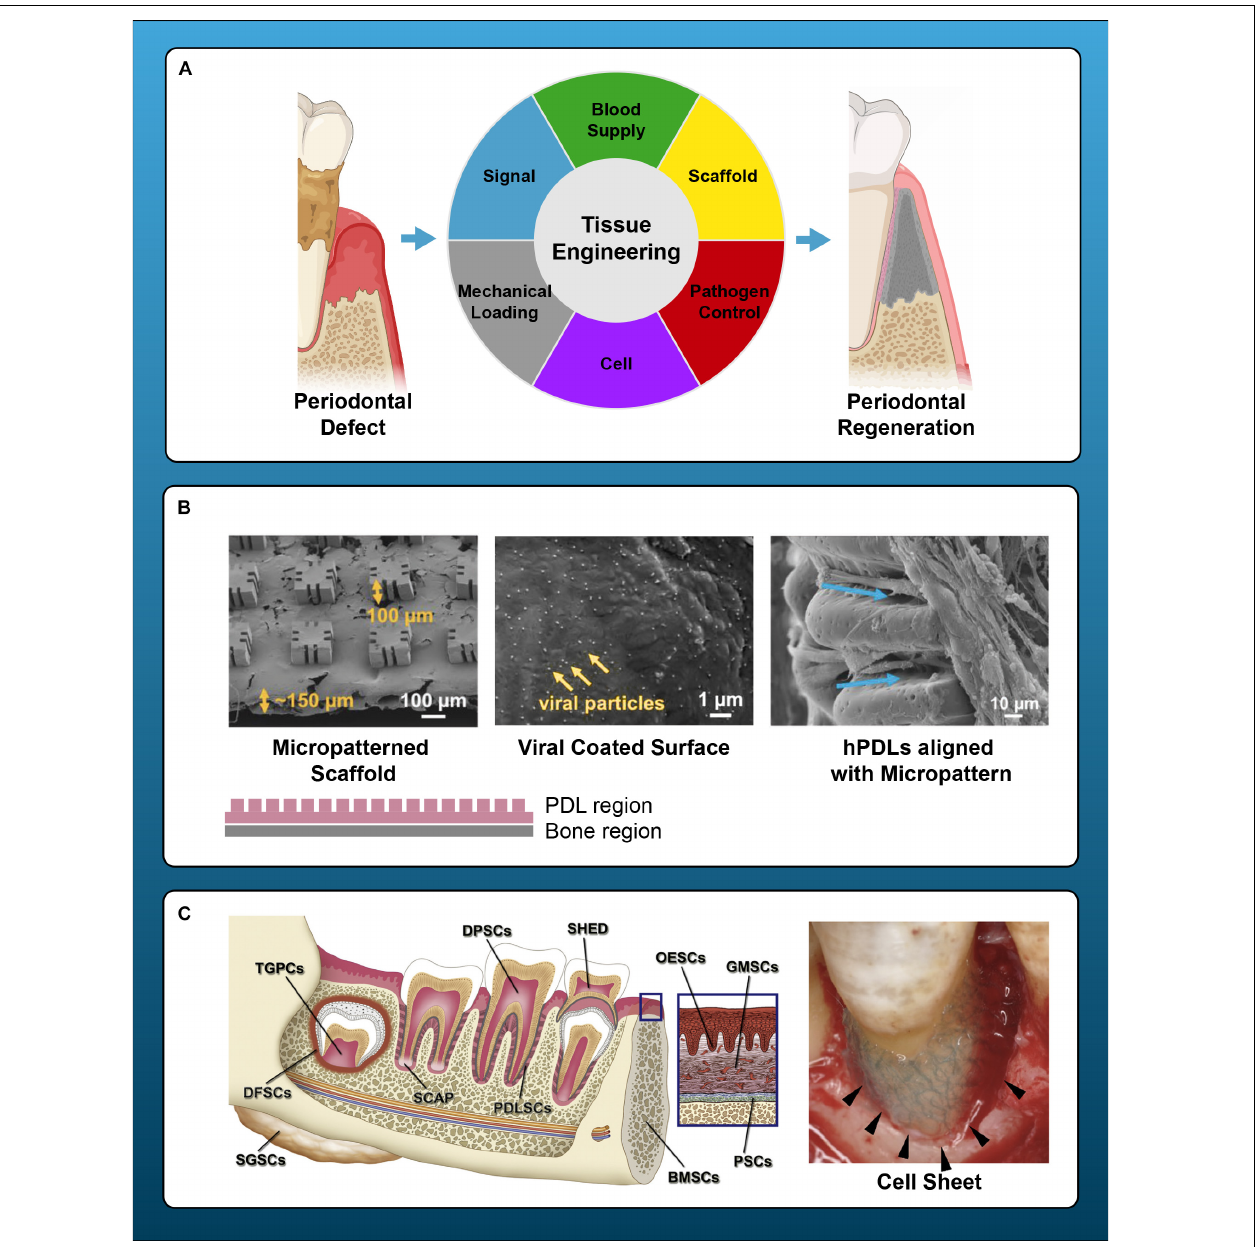
FIGURE 1 | Principles and current endeavors for periodontal regeneration with tissue bioengineering. (A) Key components of periodontal regeneration with tissue engineering. Cells, growth factors, scaffold, mechanical loading, pathogen control, and ideal blood supply are the key for periodontal regeneration. (B) Examples of micropatterned scaffold, which enhances the orientation of fiber in periodontal regeneration. Left panel: SEM image of a micropatterned scaffold with grooves. Center: Viral Gene delivery (Ad-BMP-7) with chemical vapor deposition. Right: human PDL cells aligned along with the grooves of micropattern. (C) Left: prospective sources of stem cells in dental and maxillofacial region. BMSCs, bone marrow-derived mesenchymal stem cells from orofacial bone; DPSCs, dental pulp stem cells; SHED, stem cells from human exfoliated deciduous teeth; PDLSCs, periodontal ligament stem cells; DFSCs, dental follicle stem cells; TGPCs, tooth germ progenitor cells; SCAP, stem cells from the apical papilla; OESCs, oral epithelial progenitor/stem cells; GMSCs, gingiva-derived MSCs; PSCs, periosteum-derived stem cells; SGSCs, salivary gland-derived stem cells. Right: autologous PDL-derived a three-layered cell sheet with woven PGA. Adapted with permission from Egusa et al. (2012), Iwata et al. (2018), Pilipchuk et al. (2018), and Yu et al.